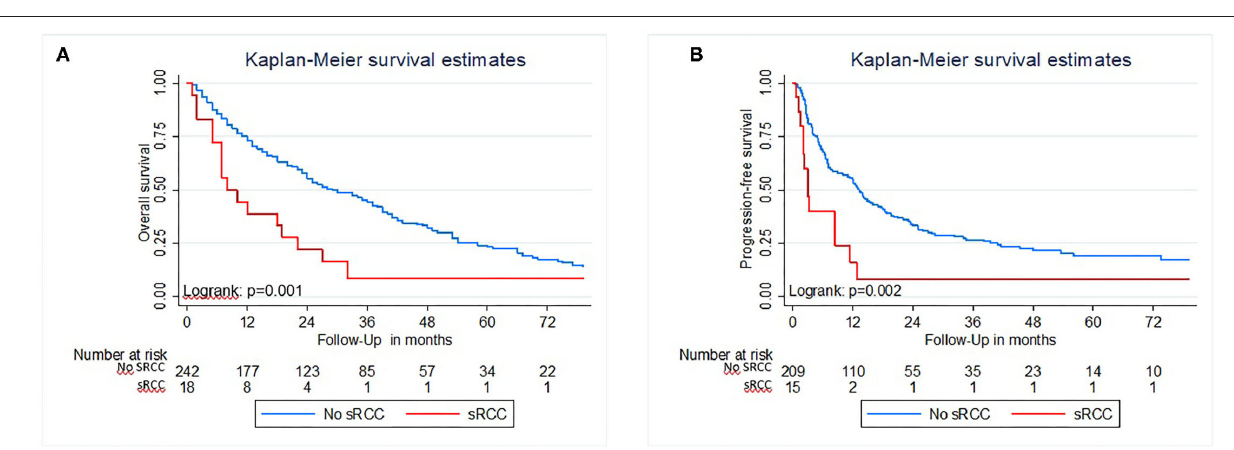
Sunitinib, Sorafenib, and Pazopanib. Due to the small patient number, no multivariable Cox regression was performed. There was no difference for each endpoint in any other treatment subgroup analysis (all p ≥ 0.05; Figures 3C–K